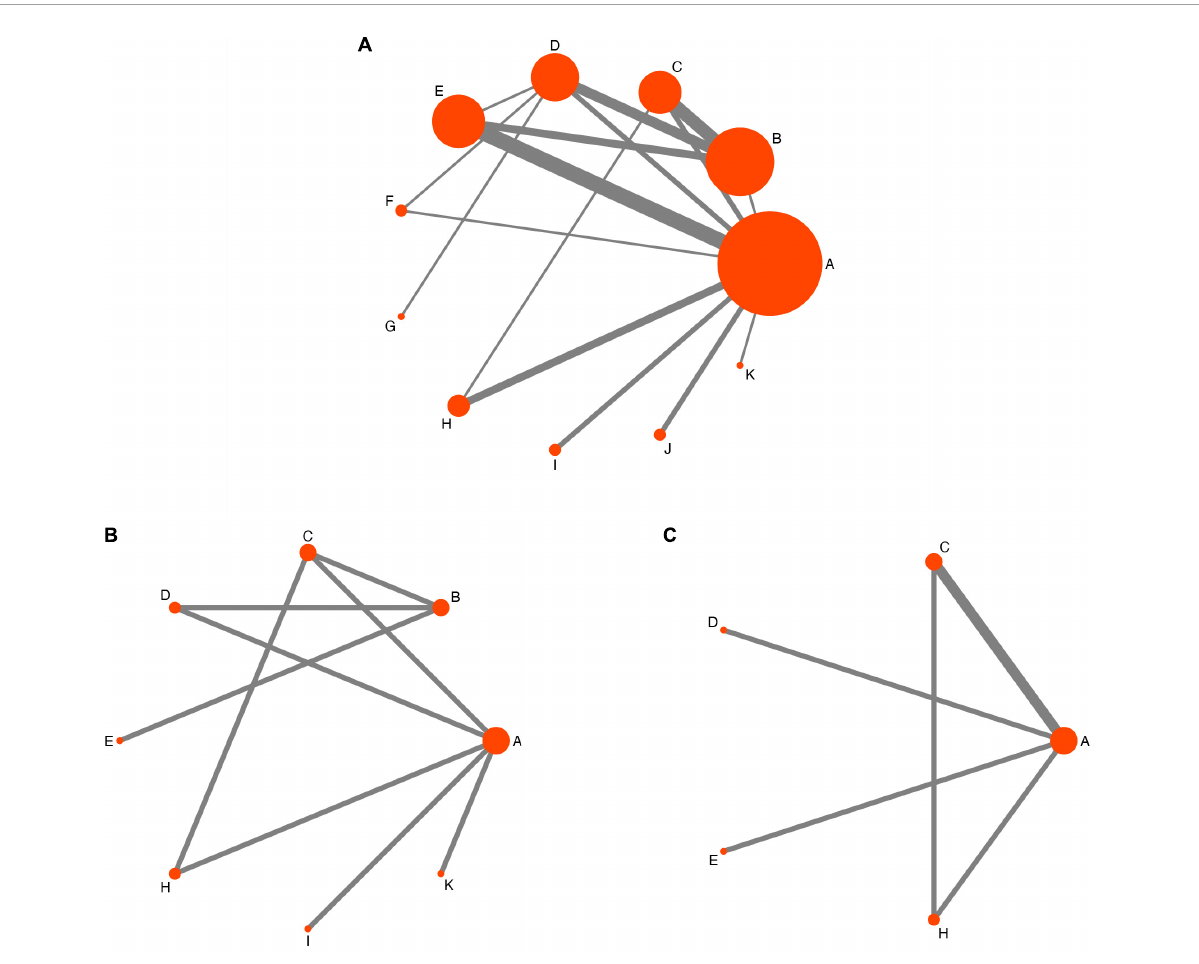
FIGURE3 Network evidence diagram. A = antiepileptics; B = manual acupuncture; C = electroacupuncture; D = fire needling; E = pricking and cupping; F = Fu’s acupuncture; G = medicated thread moxibustion; H = electroacupuncture plus antiepileptics; I = fire needling plus antiepileptics; J = pricking and cupping plus antiepileptics; K = acupoint catgut embedding plus antiepileptics. (A) The visual analog scale, (B) the Pittsburgh Sleep Quality Index (PSQI), and (C) the Self-Rating Depression Scale (SDS) network evidence diagram.